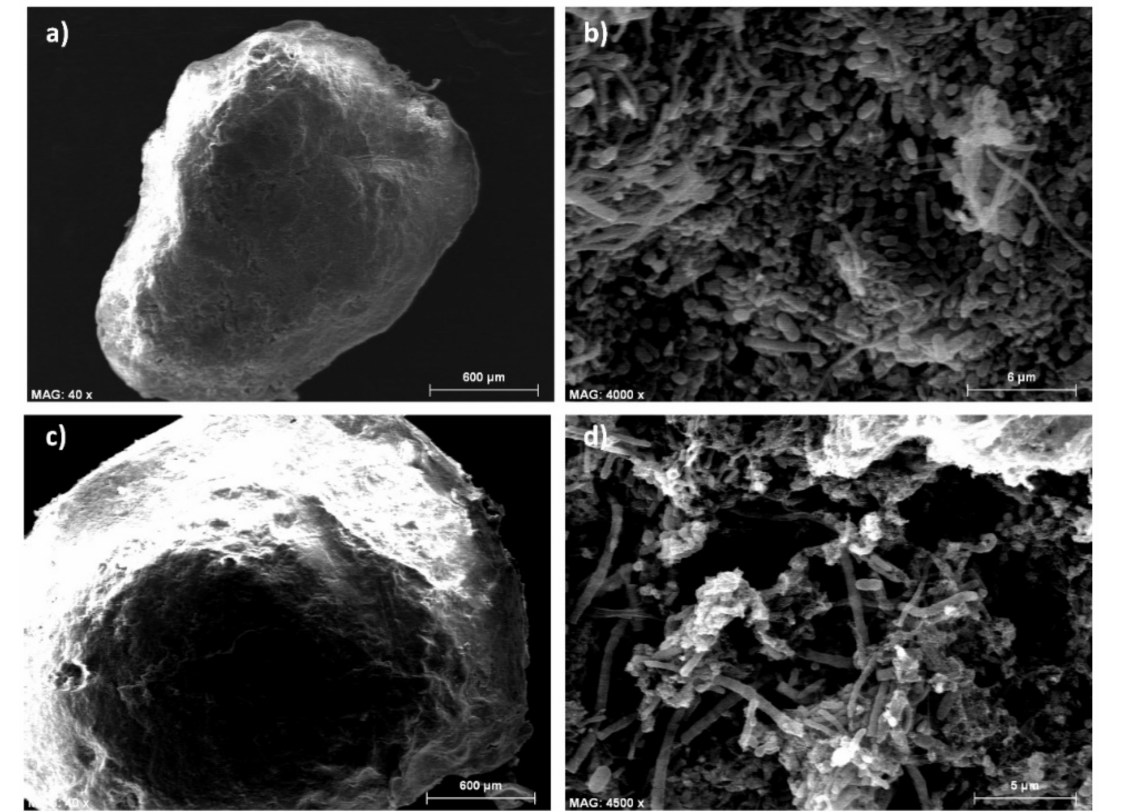
Figure 5. SEM images of morphology of the granules at the end of the study. ( a , b ) Granule from the sludge bed of R2, ( c , d ) floating granule from the sedimentation zone of